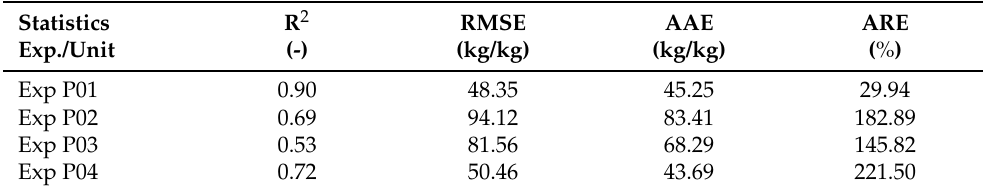
Table 4. The calculated measures of the statistics for the comparison of the experimental CSD measure- ments and the model predictions (percentiles between d10–d90 are used for the description of CSD).